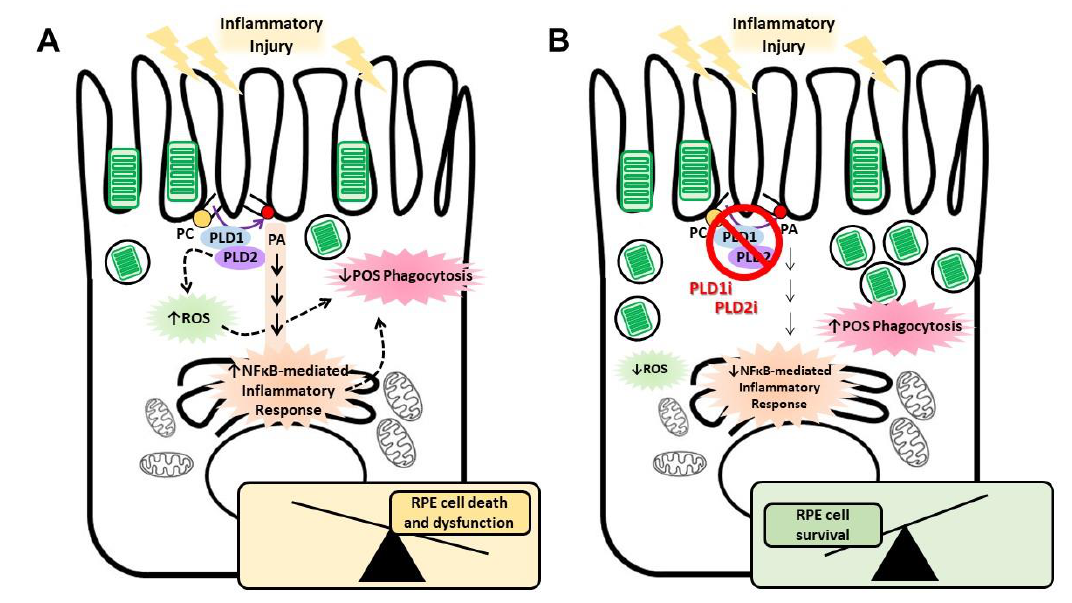
Figure 5. Schematic view of PLD-mediated events elicited in RPE cells exposed to inflammatory injury. ( A ) The PLD pathway is activated in RPE cells exposed to inflammatory injury to mediate reactive oxygen species (ROS) generation and nuclear factor kappa B (NF κ B)-mediated inflammatory response, leading to a reduced RPE cell viability and phagocytic function. ( B ) Pharmacological inhibition of PLD1 and PLD2 is able to prevent ROS generation and the RPE inflammatory response, resulting in a normal phagocytic function. Dashed arrows indicate possible but not fully elucidated mechanisms.